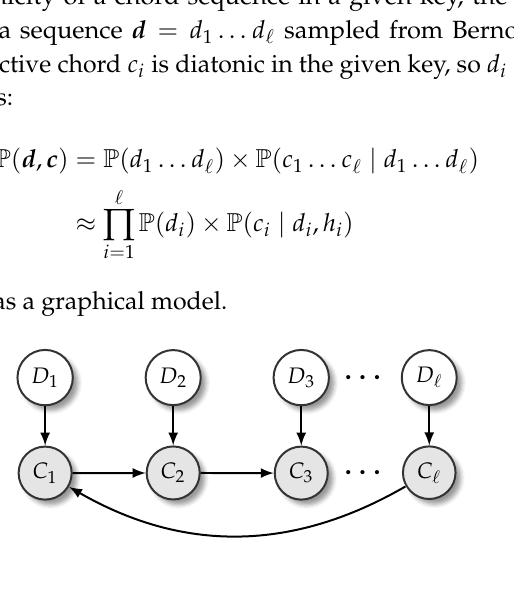
Figure 3. The basic cyclic model extended with diatonicity